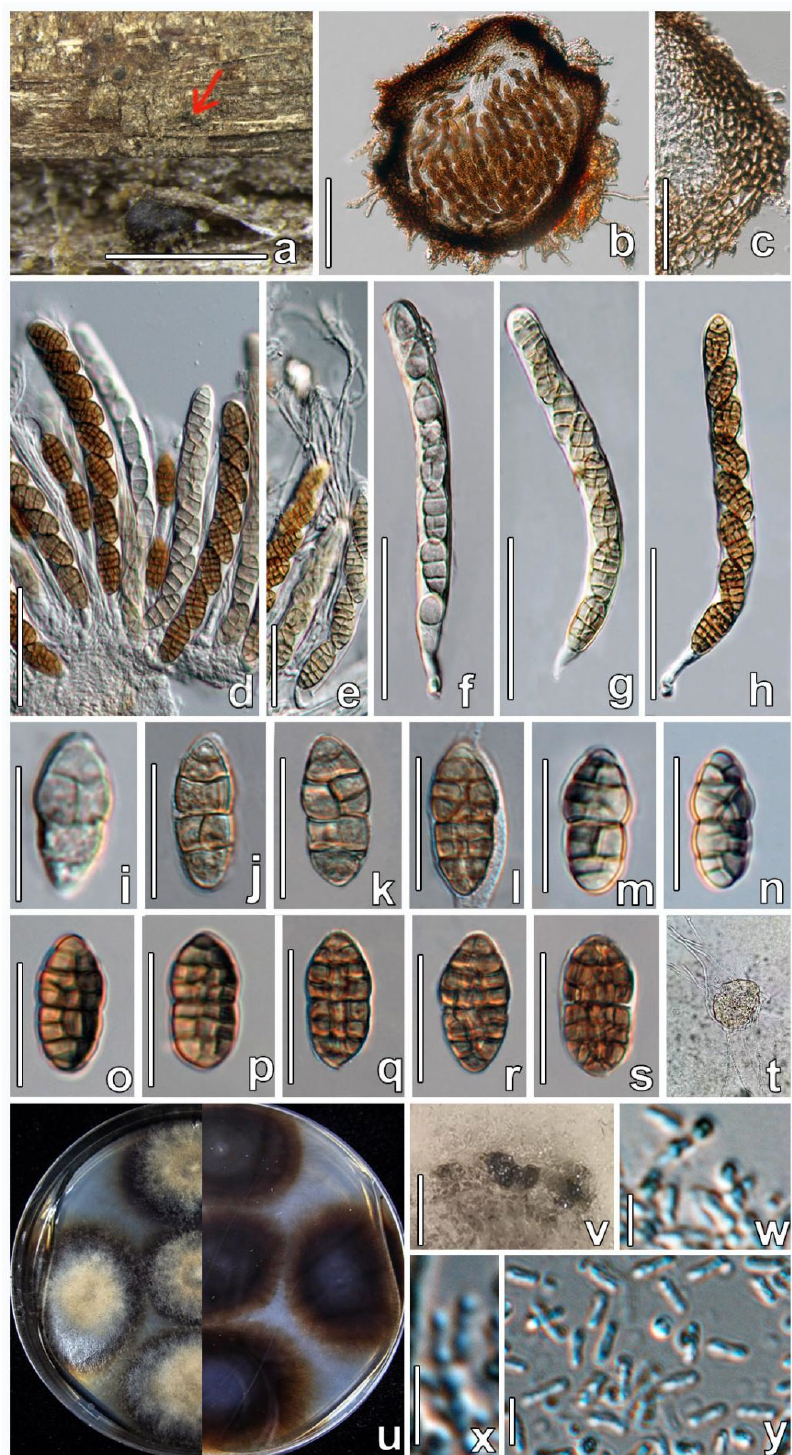
Figure 6. Parafenestella ulmi (HMJAU 60178, holotype ). ( a ) Ascomata on host surface. ( b ) Vertical section through ascoma. ( c ) Partial peridium in vertical section. ( d , e ) Asci arrangement along with pseudoparaphyses. ( f – h ) Development stages of asci. ( i – s ) Development stages of ascospores. ( t ) Germinating ascospore. ( u ) Four-week-old culture characteristics on PDA. ( v ) Pycnidia formed in sterile culture after two weeks of incubation on PDA. ( w , x ) Conidiogenous cells and conidia. ( y ) Conidia. Scale bars: ( a ) = 500 µ m; ( b ) = 100 µ m; ( c – h ) = 50 µ m; ( i – s ) = 20 µ m; ( v ) = 200 µ m; ( w – y ) = 5 µ